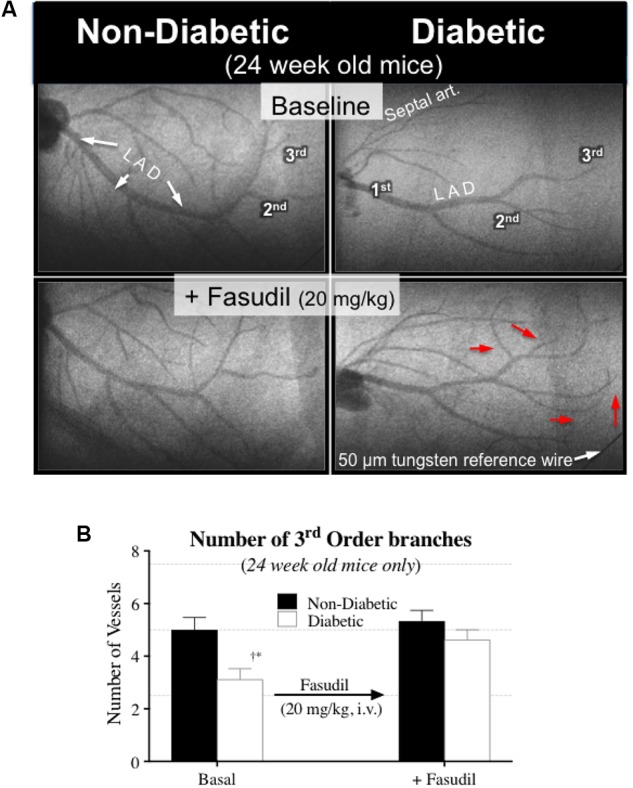
(A) Microangiogram images showing the effect of fasudil (20 mg/kg, i.v.) in improving coronary blood flow distribution in 24-week-old diabetic mice, via the recruitment of additional 3rd order branches (red arrows). (B) Quantitative data (mean ± SEM) of the coronary angiograms showing an increase in the number of 3rd order branches in the 24-week-old diabetic mice (n = 8) following fasudil administration. ∗Significant difference between diabetic and non-diabetic mice (P < 0.05). †Significantly different from 8 weeks of age (P < 0.05).